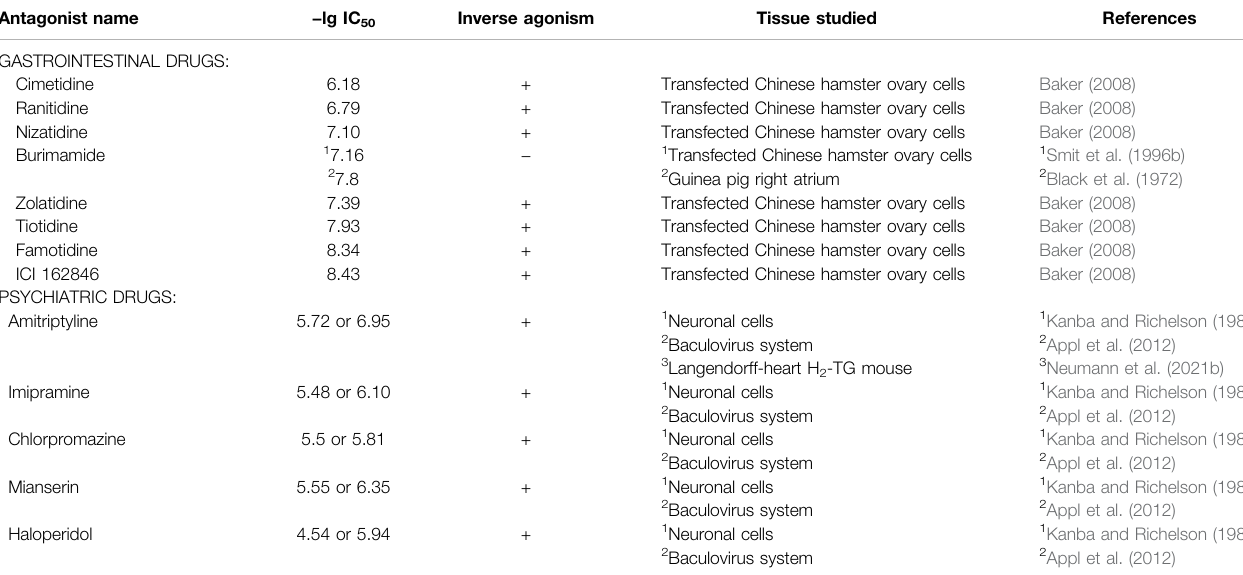
TABLE 2 | Antagonists at H 2 -histamine receptors.